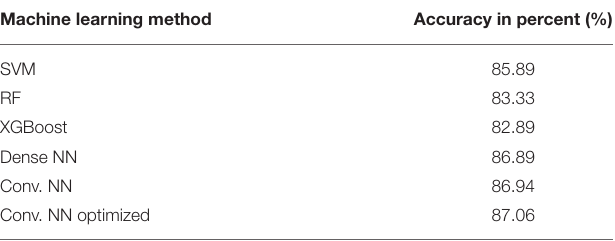
TABLE 2 | Achieved accuracy per method for initial visitation dataset: table showing the executed ML-methods and the achieved accuracy on Initial-Total dataset in percent.